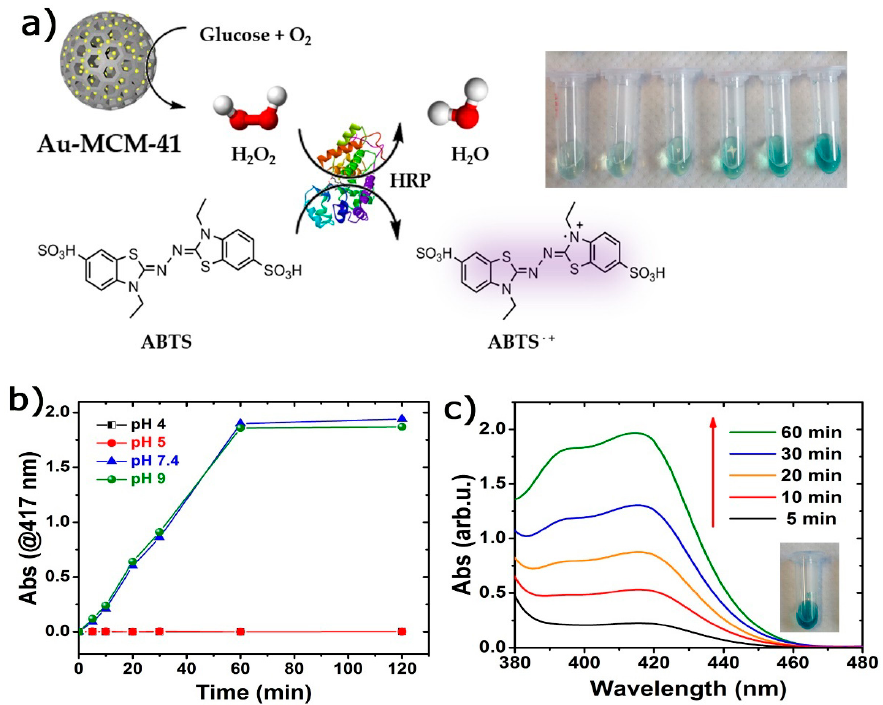
Figure 4. Colorimetric determination of the presence of hydrogen peroxide as reaction product retrieved from the glucose oxidation reaction (using the ABTS mediated assay): ( a ) Schematic display of the formation of hydrogen peroxide and its subsequent redox reaction mediated by a horseradish enzyme that readily reacts with ABTS to render the blue colored oxidized derivative with maximum absorption spectrum centered at 415 nm; (inset: digital image showing the evolution of the blue-colored vials upon increasing reaction times related to increasing formation of H 2 O 2 ); ( b ) Time-dependent evolution of the maximum absorption of ABTS(ox) at different pH conditions and keeping reaction temperatures of 37 °C; ( c ) Representative UV-Vis spectra of the ABTS(ox) molecule at increasing reaction time intervals; Experimental conditions: [catalyst] = 0.025 mg/mL; [glucose] = 150 mM; reaction media buffered with 0.2 M sodium acetate/acetic acid.